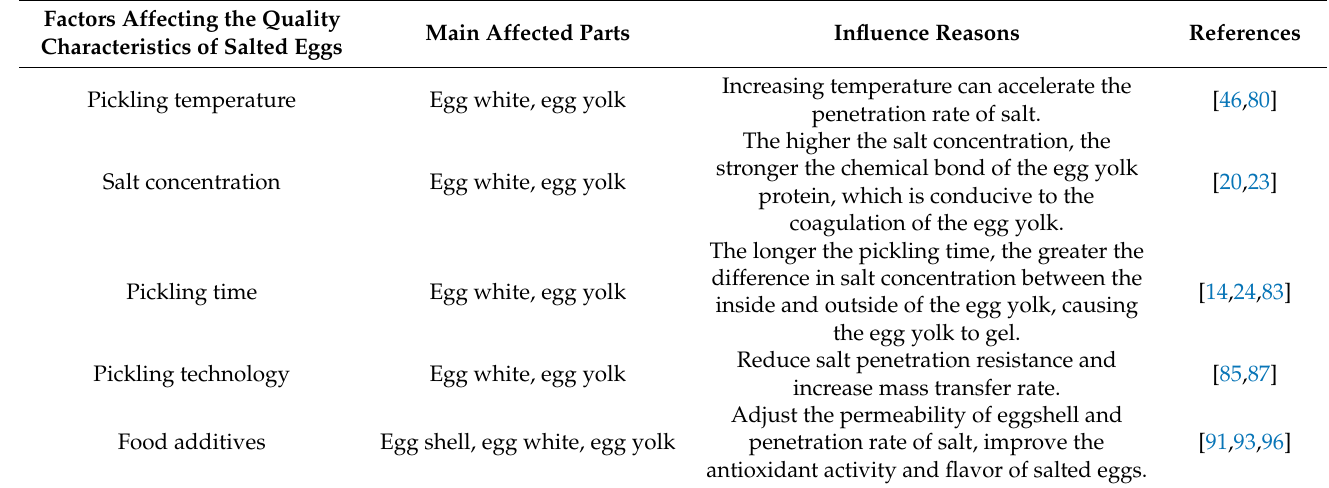
Figure 6. Diagram of the factors affecting the quality of salted eggs. Table 2. Factors affecting the quality characteristics of salted eggs.